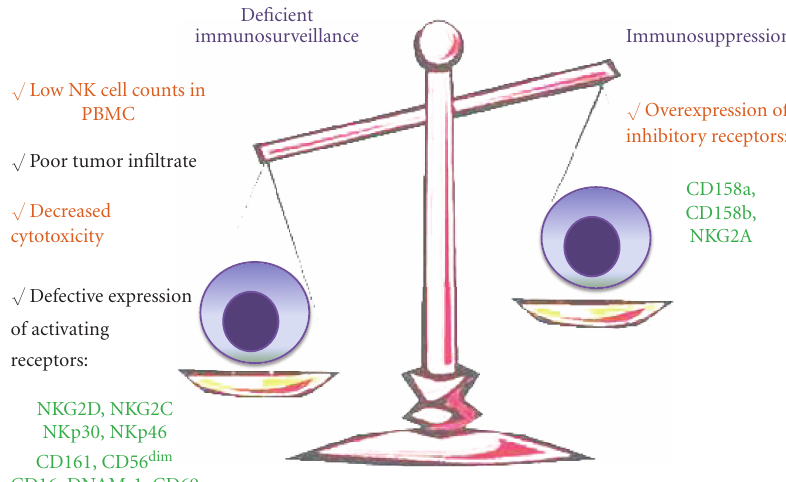
Figure 1: NK cell abnormalities in cancer patients. A defective immunity secondary to tumor development has been well established in di ff erent types of cancer. The imbalance of immune status is inclined to immunosuppression in cancer patients which results in a concomitant tendency to tumor immune evasion. Such immunosuppression is characterized by a decrease in NK cell numbers in PB and a decreased in tumor infiltrate as compared to normal tissue. Moreover, in many types of cancer an altered phenotype which presents defective expression of activating receptors and overexpression of inhibitory receptors is